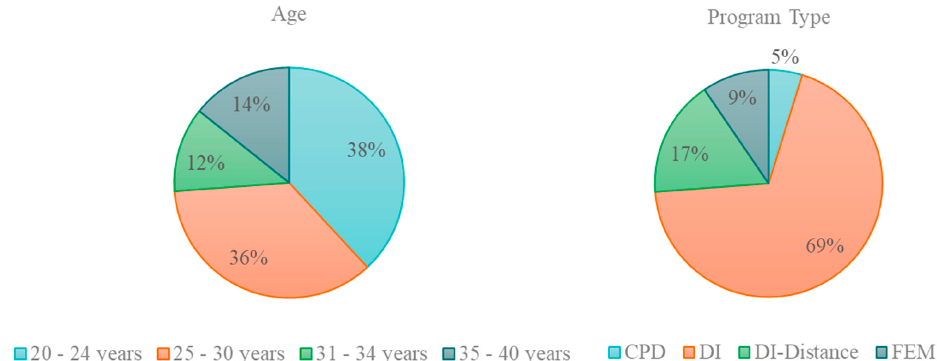
Figure 1. Dietetic intern participants’ ( n = 42) age and program type. CPD = Coordinated Program in Dietetics (Bachelor’s and graduate level—dietitian coursework and at least 1000 h of supervised practice for RDN eligibility (combined program). DI = Dietetic Internship (Post-bachelor’s—at least 1000 h of supervised practice only for RDN eligibility). FEM = Future Education Model (Graduate- level, competency-based dietitian nutritionist program that integrates coursework and at least 1000 h of experiential learning for RDN eligibility).